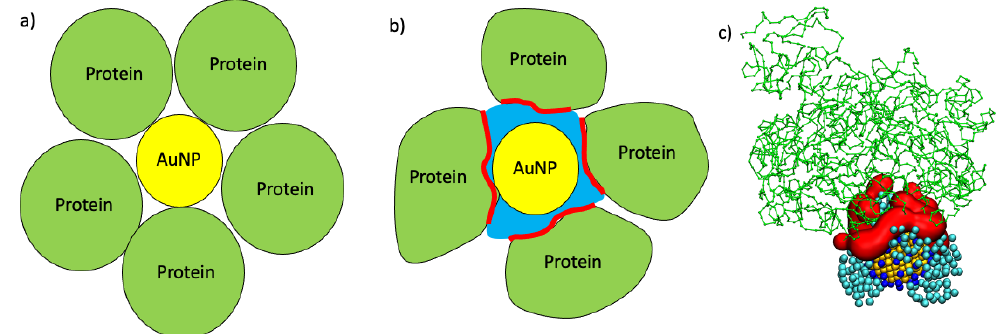
Figure 7. In panel ( a ), a sketch of the maximum number of proteins that can absorb on the AuNP in the geometrical case where both the AuNP and the proteins are treated as rigid spheres is shown. In panel ( b ), a sketch of a real case where the AuNP is surrounded by the ligands (in blue) and where the proteins are not perfect spheres but instead adapt to the AuNP surface is shown. The red line represents the binding site of the proteins. Panel ( c ) shows the adsorption of complement c3 (in green) over the all-MUS AuNP, where the interacting surface is highlighted in red.